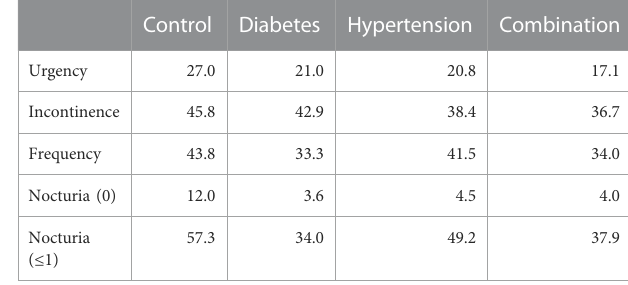
TABLE4PatientsbecomingfreeofagivensymptomupontreatmentinstudyII Data are shown as % of patients who had exhibited a symptom at baseline but didnotatendofstudy.Notexhibitingasymptomwasde fi nedas0forurgency and incontinence and as ≤ 7 for micturition frequency. For nocturia it was de fi ned as 0 or as ≤